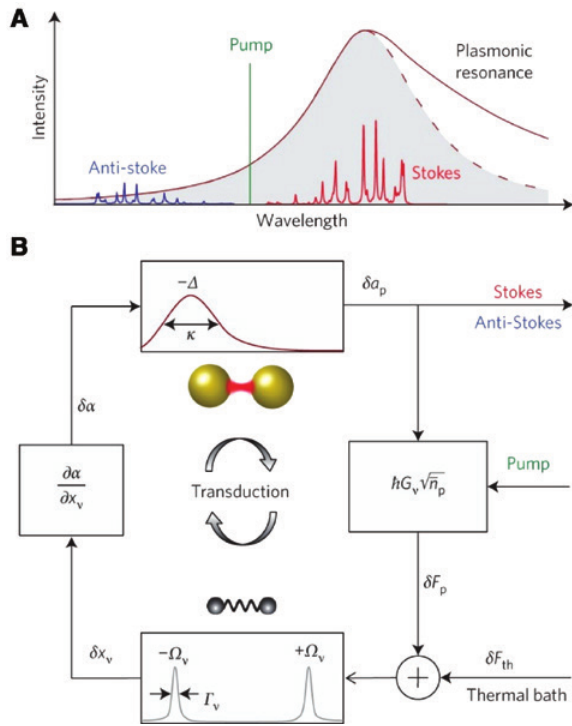
Figure 11: Dynamical backaction scheme for